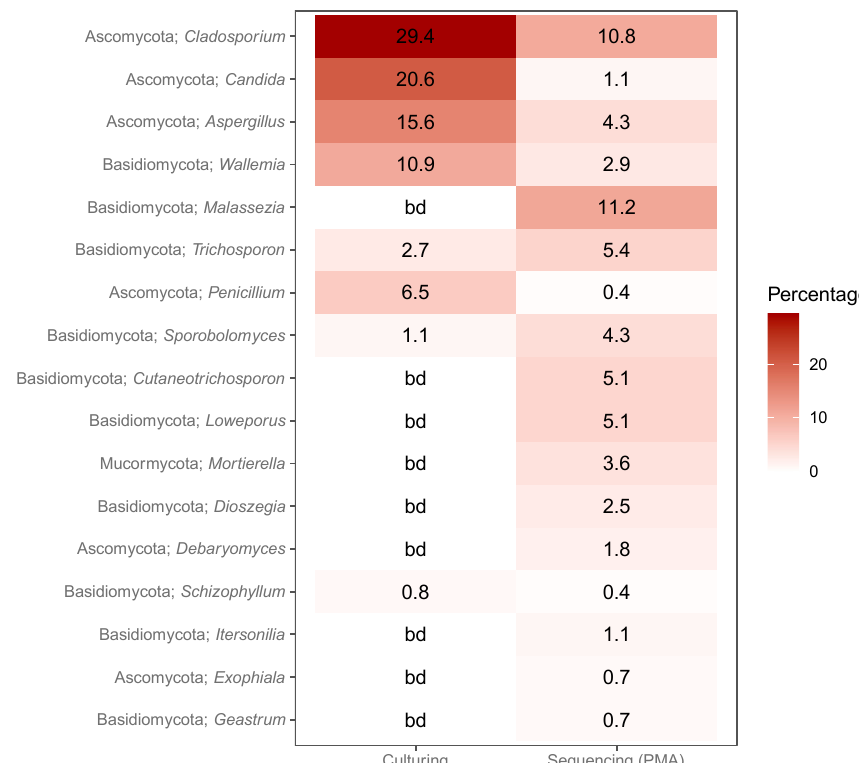
Figure 4. Heatmap showing the percentage of positive samples with genera identified in both sequencing of samples treated with PMA and culture-based methods. For each sample type (culturing and sequencing) the percentage of positive identifications within that sample type is given. bd: below detection limit.